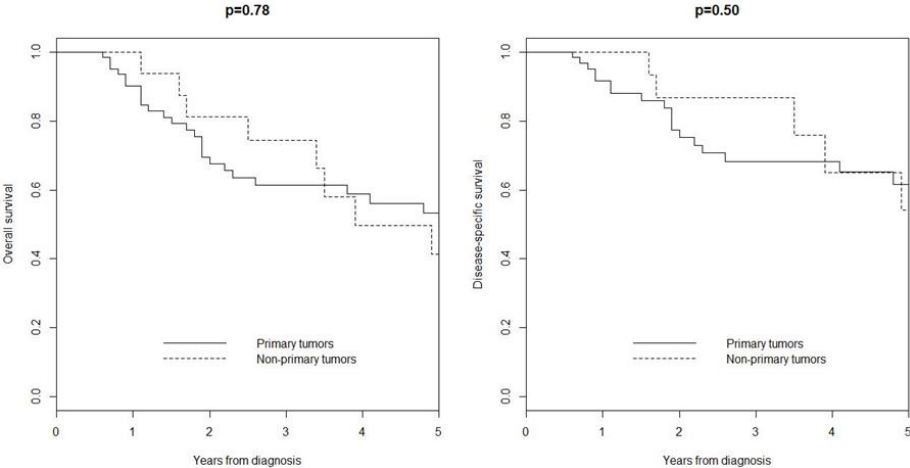
Figure 3. Overall survival and disease-specific survival in patients with tumor stage I–III.